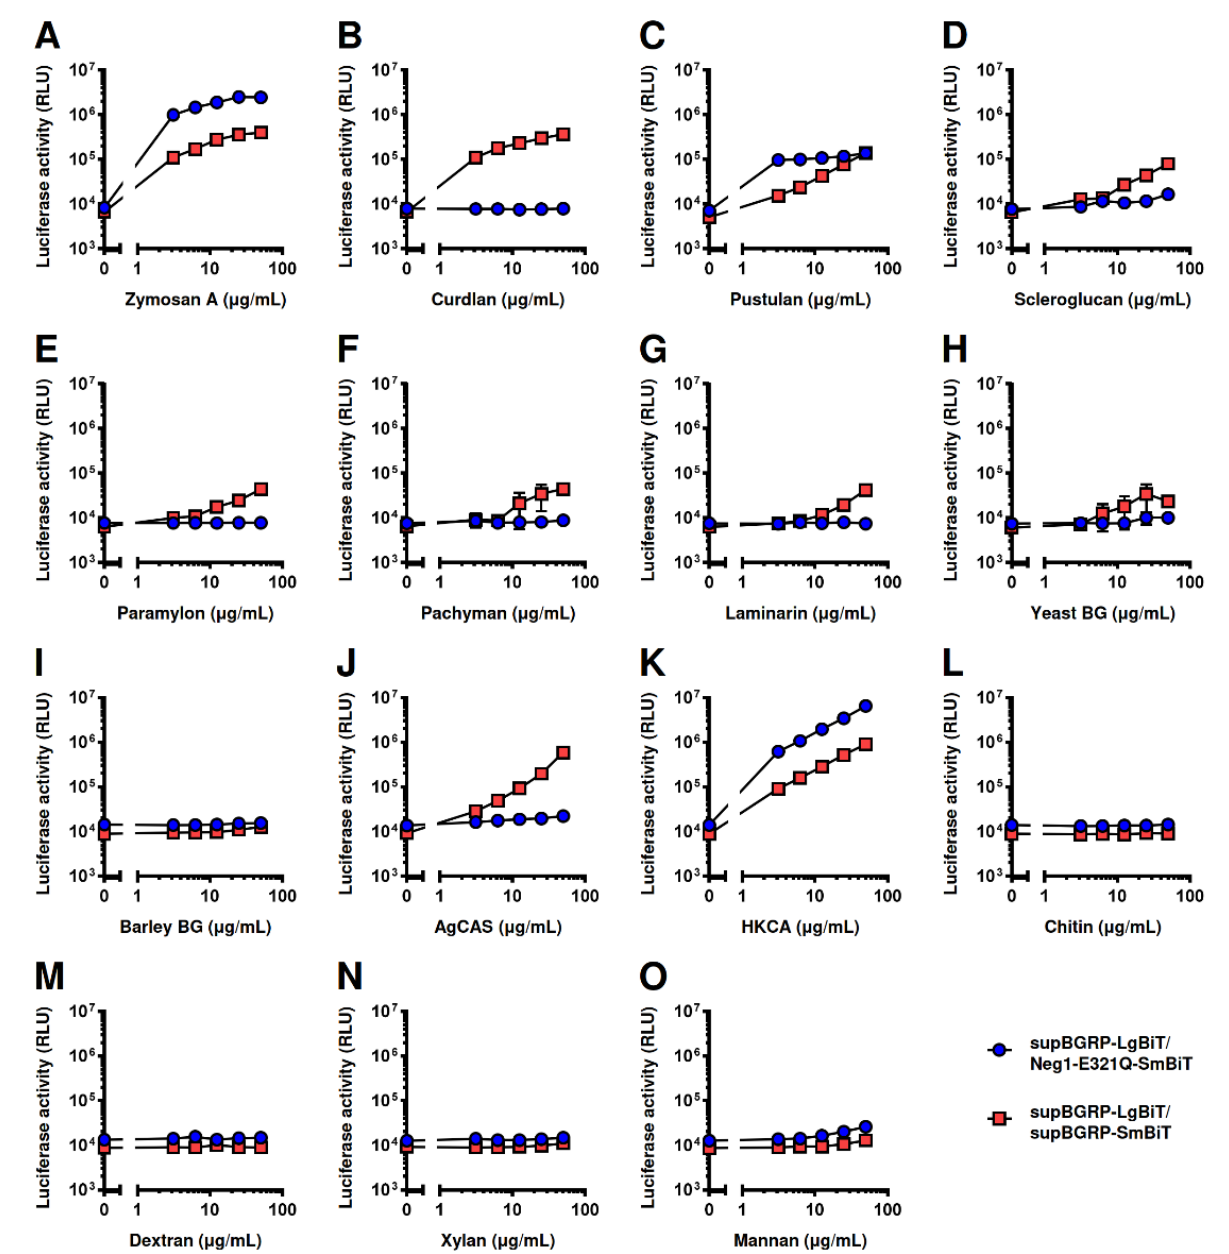
Figure 4. Measurement of various glucan samples using split-NanoLuc complementation assay. The mixture solution of supBGRP-LgBiT and Neg1-E321Q-SmBiT (200 nM each, 5 µ L) for β -1,6-branched β -1,3- D -glucan or supBGRP-LgBiT and supBGRP-SmBiT (200 nM each, 5 µ L) for β -1,3- D -glucan was incubated with test samples, ( A ) zymosan A, ( B ) curdlan, ( C ) pustulan, ( D ) scleroglucan, ( E ) paramylon, ( F ) pachyman, ( G ) laminarin, ( H ) yeast BG, ( I ) barley BG, ( J ) AgCAS, ( K ) HKCA, ( L ) chitin, ( M ) dextran, ( N ) xylan, and ( O ) mannan (0–50 µ g/mL each). After 30 min, 15 µ L of furimazine solution were added and reconstituted NanoLuc activity measured. Data are presented as the mean ± SD of values in duplicates and are representative results from at least two independent experiments.